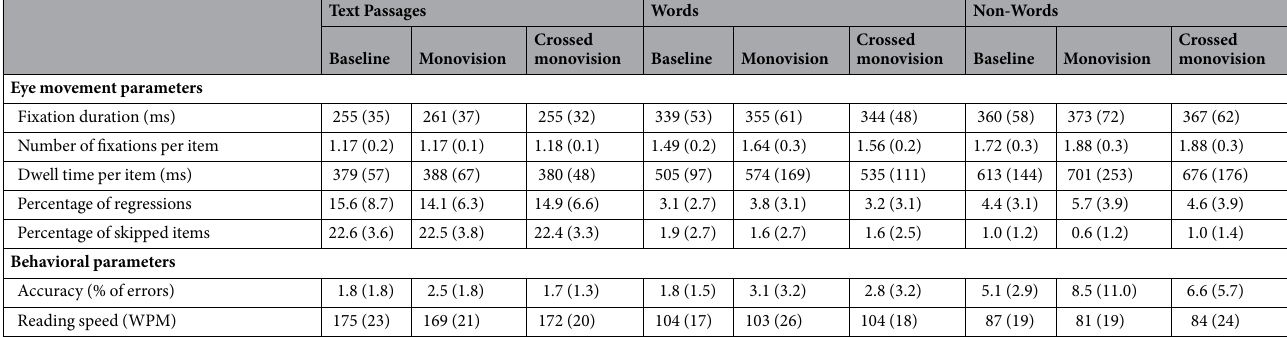
Table 3. Group means (and standard deviations in parentheses) for eye movement and behavioral parameters measured while reading text passages, and word and non-word arrays, separately for the three CL conditions.